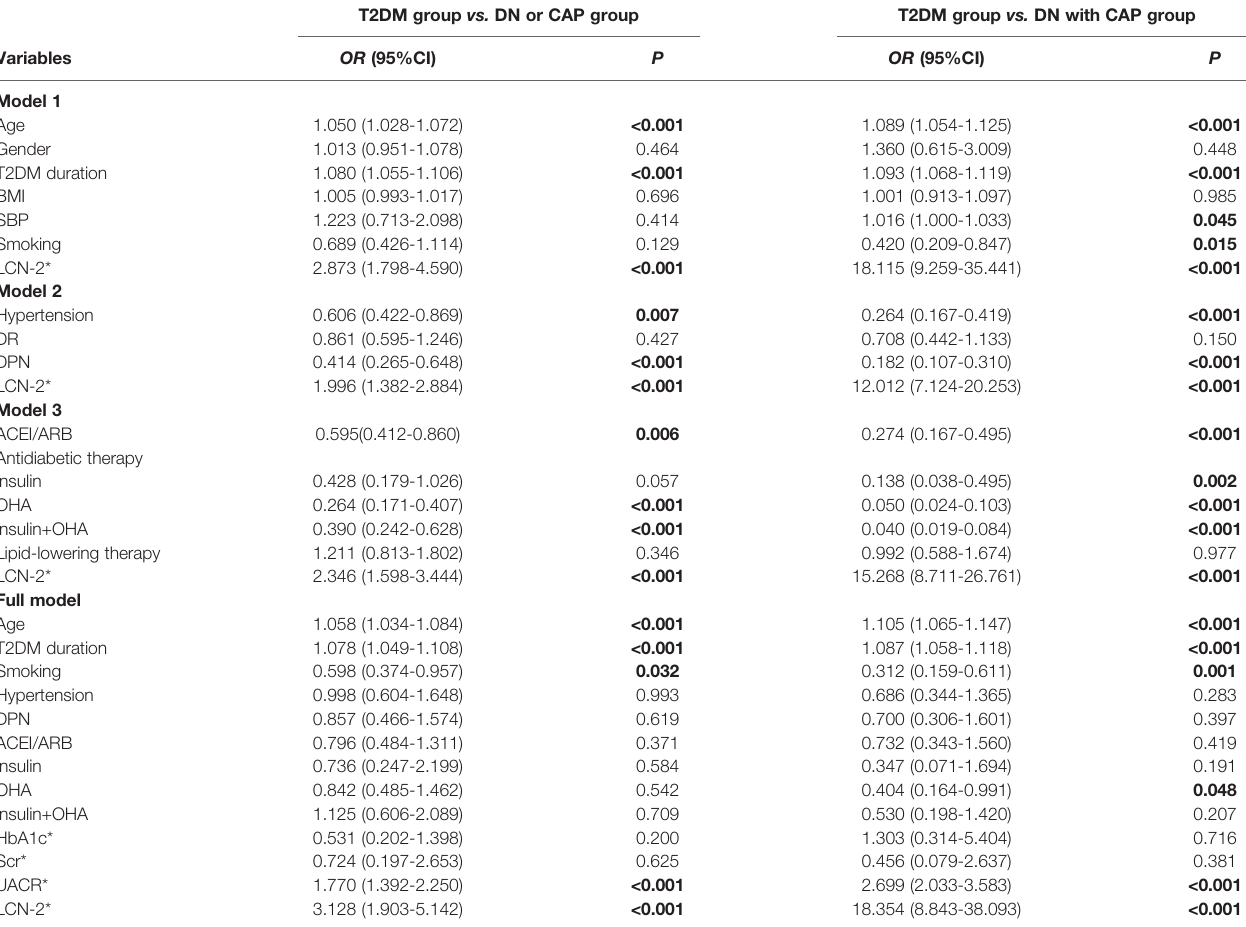
TABLE 4 | Multinomial logistic regression showing whether LCN-2 was an independent in fl uencing factor for DN and CAP. T2DM group vs. DN or CAP